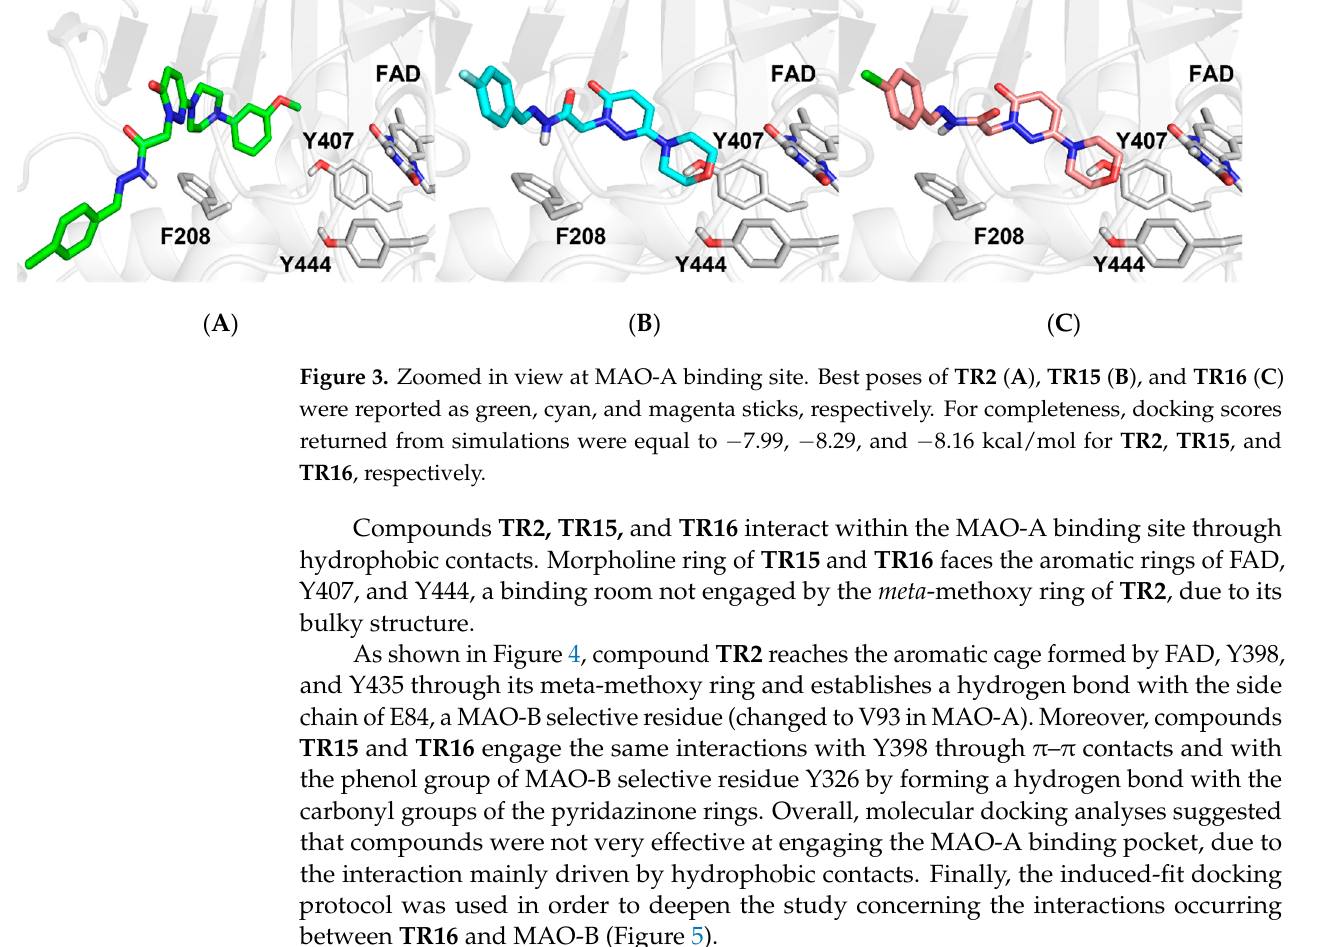
Figure 4. Zoomed in view at MAO-B binding site. Best poses of TR2 ( A ), TR15 ( B ), and TR16 ( C ) were reported as green, cyan, and magenta sticks, respectively. Red arrows and green lines indi- cate hydrogen bonds and π – π contacts, respectively. For completeness, docking scores returned from simulations were equal to − 10.051, − 9.452 and − 8.558 kcal/mol for TR2 , TR15 and TR16 , re- spectively.